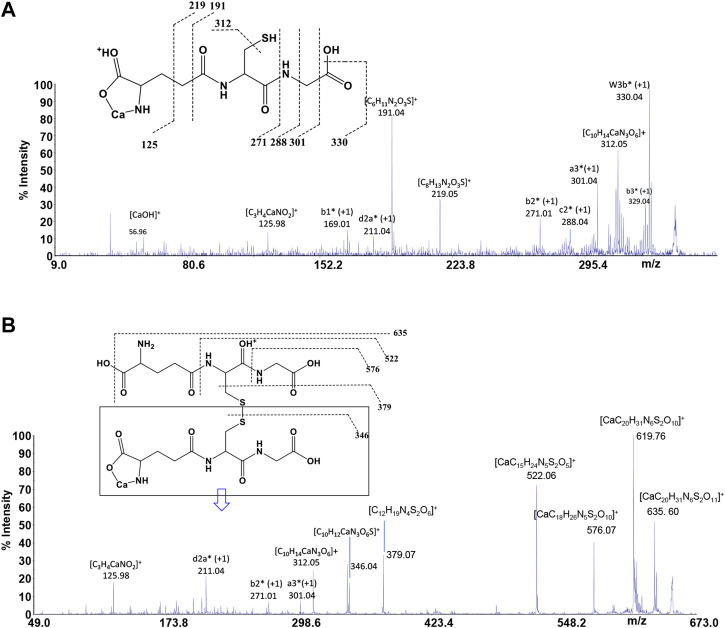
MS/MS spectrum of (A)
GSH and (B)
GSSG in the presence of Ca2+.